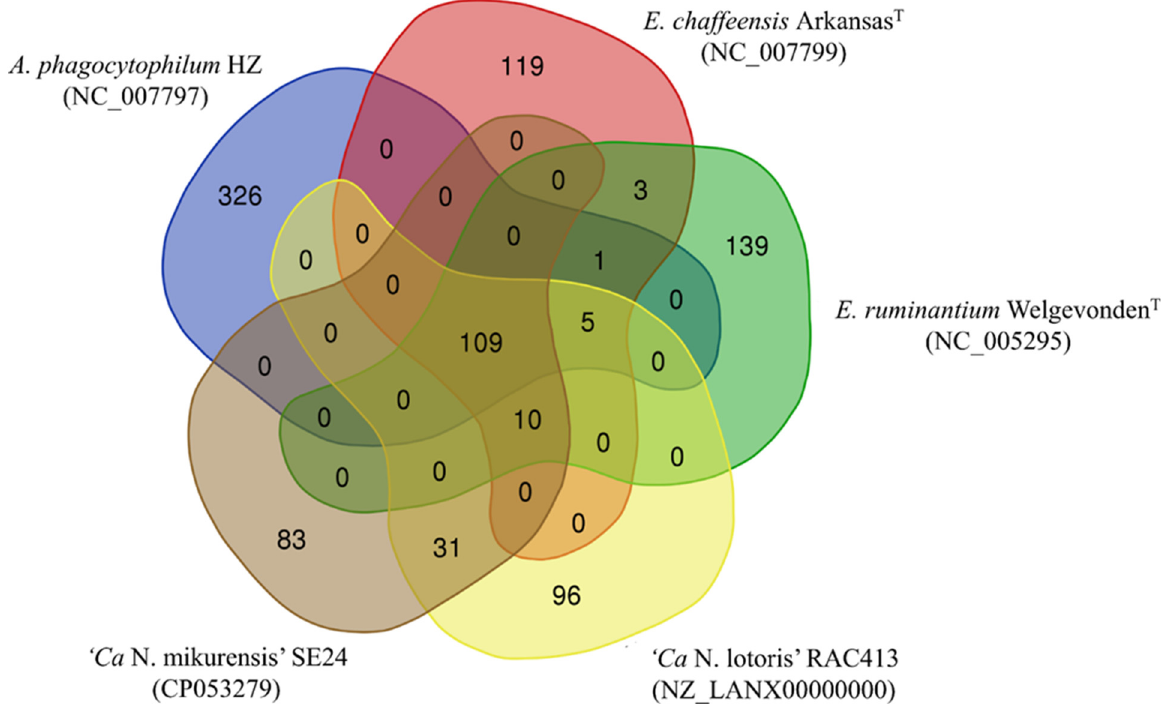
Figure 5. A consensus Venn diagram based on the clusters of homologous proteins detected by the algorithms COGT and OrthoMCL. The numbers of proteins predicted to be unique and shared, respectively, between Ca. N. mikurensis strain SE24 and four other bacterial species that are members of the family Anaplasmataceae, are shown.